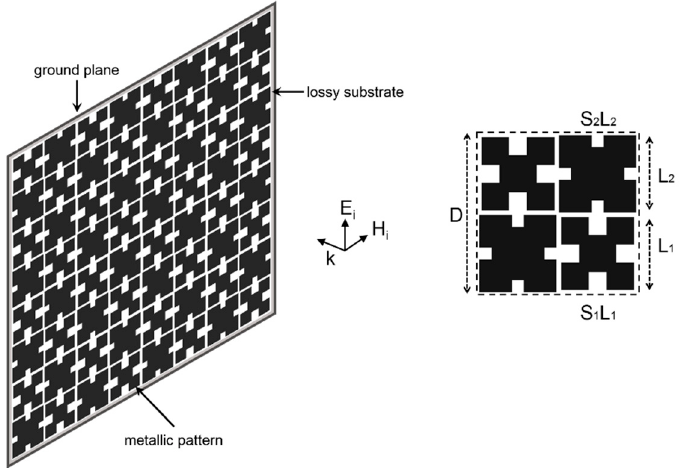
Figure 1. Fractal metamaterial absorber: dual-band unit cell.